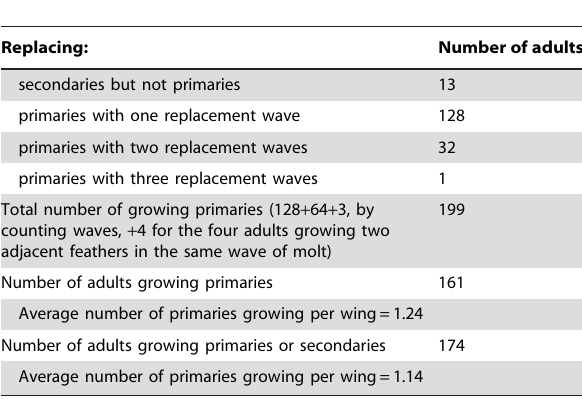
Table 4. Summary of primary molt data for 174 adult Hemiprocne mystacea that were replacing primaries or secondaries when collected (5 adults in primary molt were excluded because their molt was anomalous).